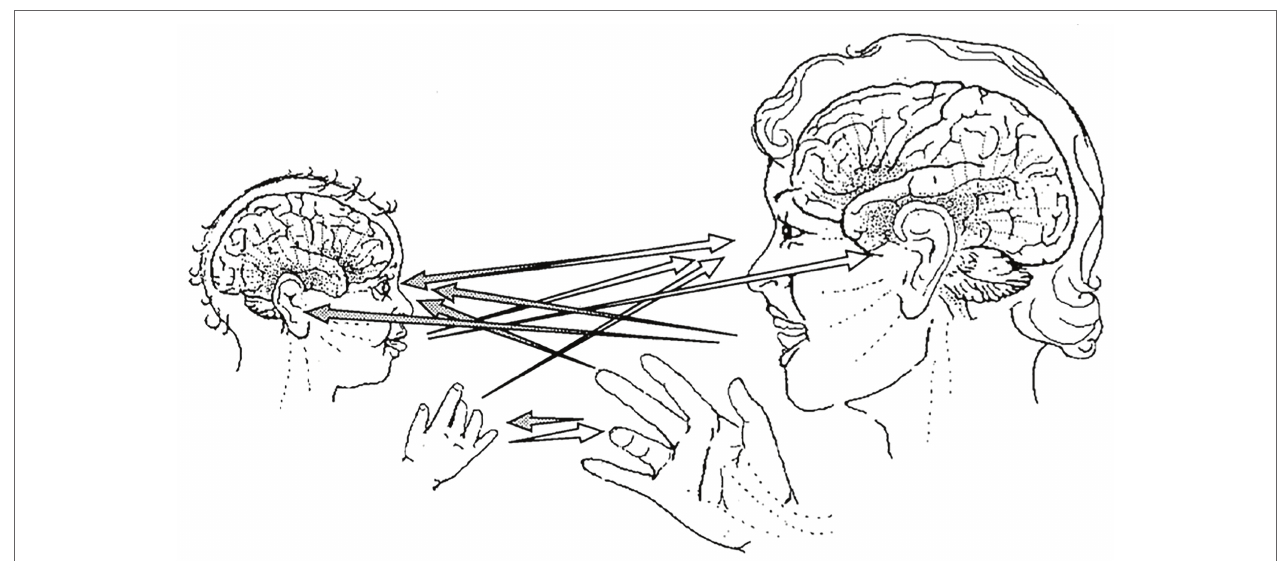
FIGURE 1 | Channels of face-to-face communication in primary intersubjectivity. Protoconversation is mediated by synchronized intersubjective eye-to-eye orientations, vocalizations, hand gestures, and movements of the arms and head, all acting in coordination to express interpersonal awareness and emotions. From Trevarthen